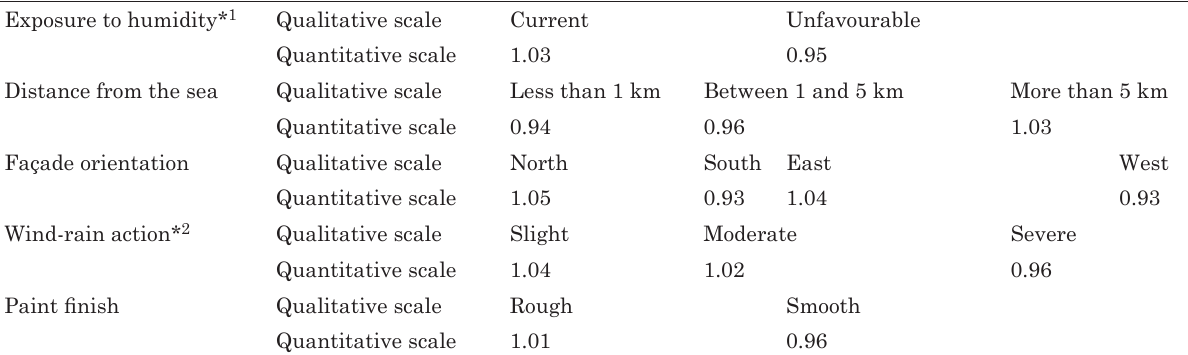
Table 3. Values adopted when converting qualitative variables into quantitative ones Exposure to humidity*